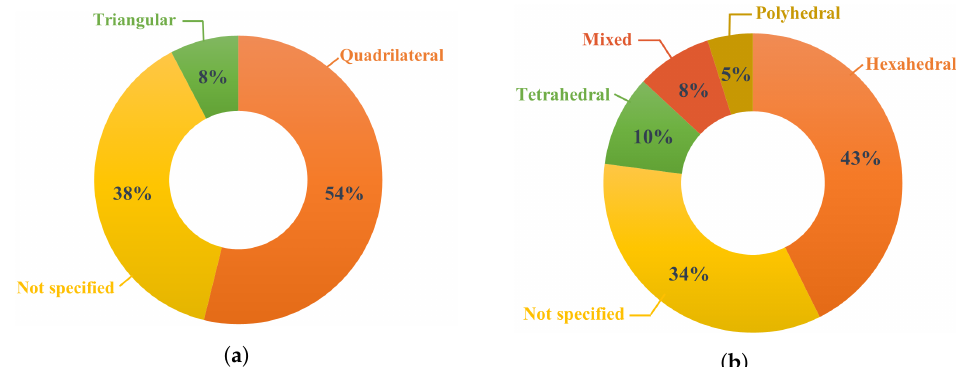
Figure 12. Cell types used in publications. ( a ) Cell types used in 2D analysis; ( b ) Cell types used in 3D